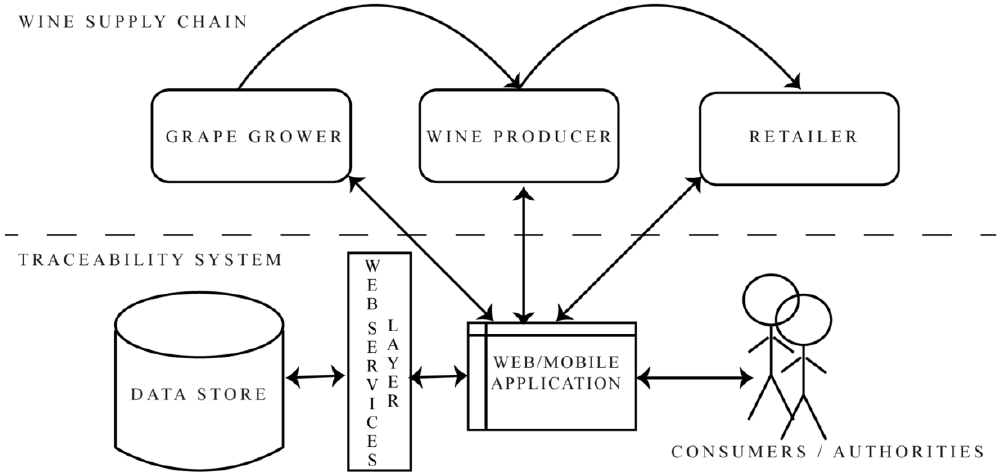
Figure 1 . The proposed prototype. The figure shows the wine supply chain in the Albanian context, integrated with an automated traceability